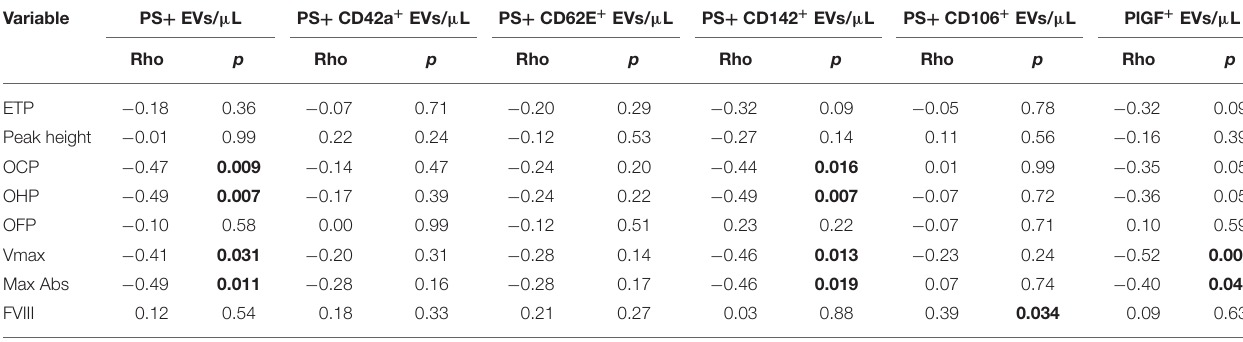
TABLE 3 | Correlation between the results of haemostatic parameters and EV concentrations.